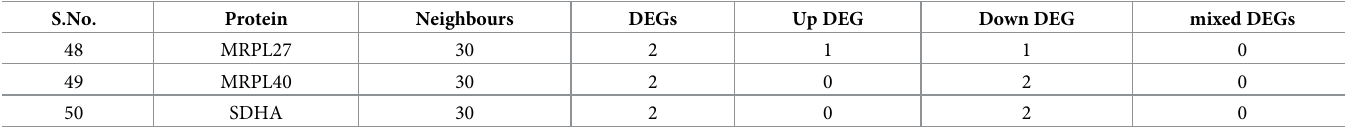
We chose four representative hubs from the top right-side rectangle to draw their subnet- works with immediate connecting proteins (points marked red in the scatter plot, Fig 3). One of these hubs, UQCR10, which is a subunit of the respiratory chain complex III, is connected to 50 proteins, including two up- and six down-regulated DEGs (Table 5). The DEGs include the up-regulated complex 1 subunit NDUFB7 and complex III subunit UQCR11; the down-